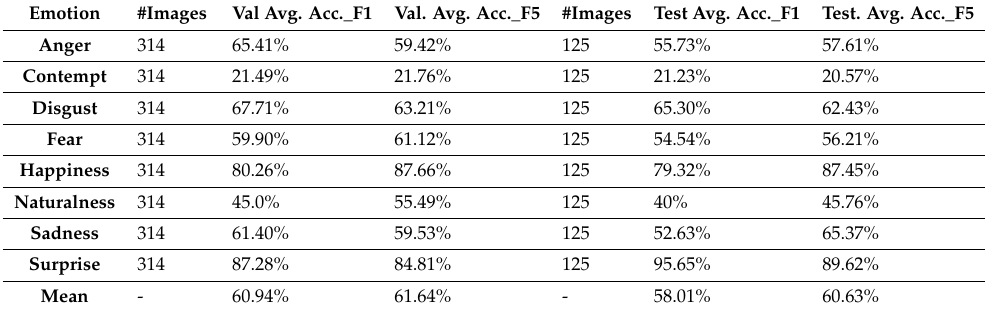
Table 7. Performance per class and average accuracy using both models, achieved with one-fold and five-fold cross-validation, on validation and test set from MIXED dataset without ELU Activa- tion Function.